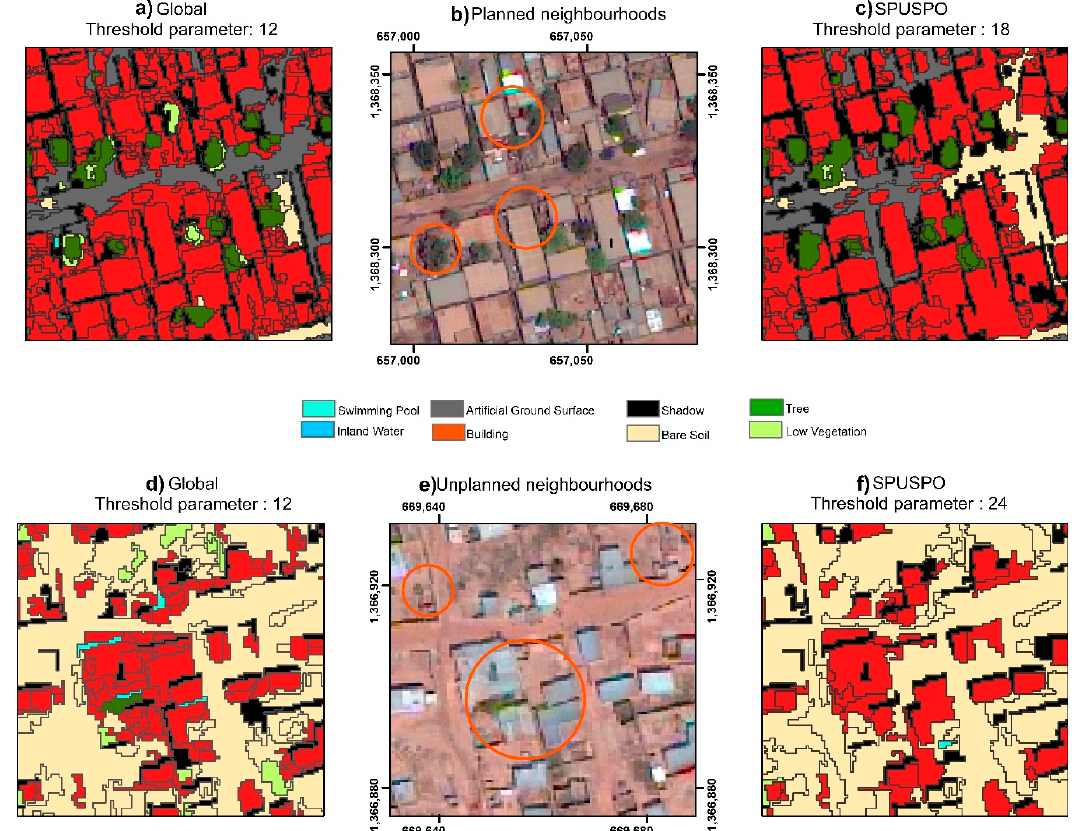
Figure 9. Example of the LULC map classification in a planned and unplanned built-up area. ( a ) LULC classification with a global approach in a planned neighborhood, ( b ) RGB Pleiades Composite, ( c ) LULC classification with a cutline approach in an unplanned neighborhood, and ( d ) LULC classification with a global approach in a planned neighborhood, ( e ) RGB Pleiades Composite, ( f ) LULC classification with a cutline approach in an unplanned neighborhood.